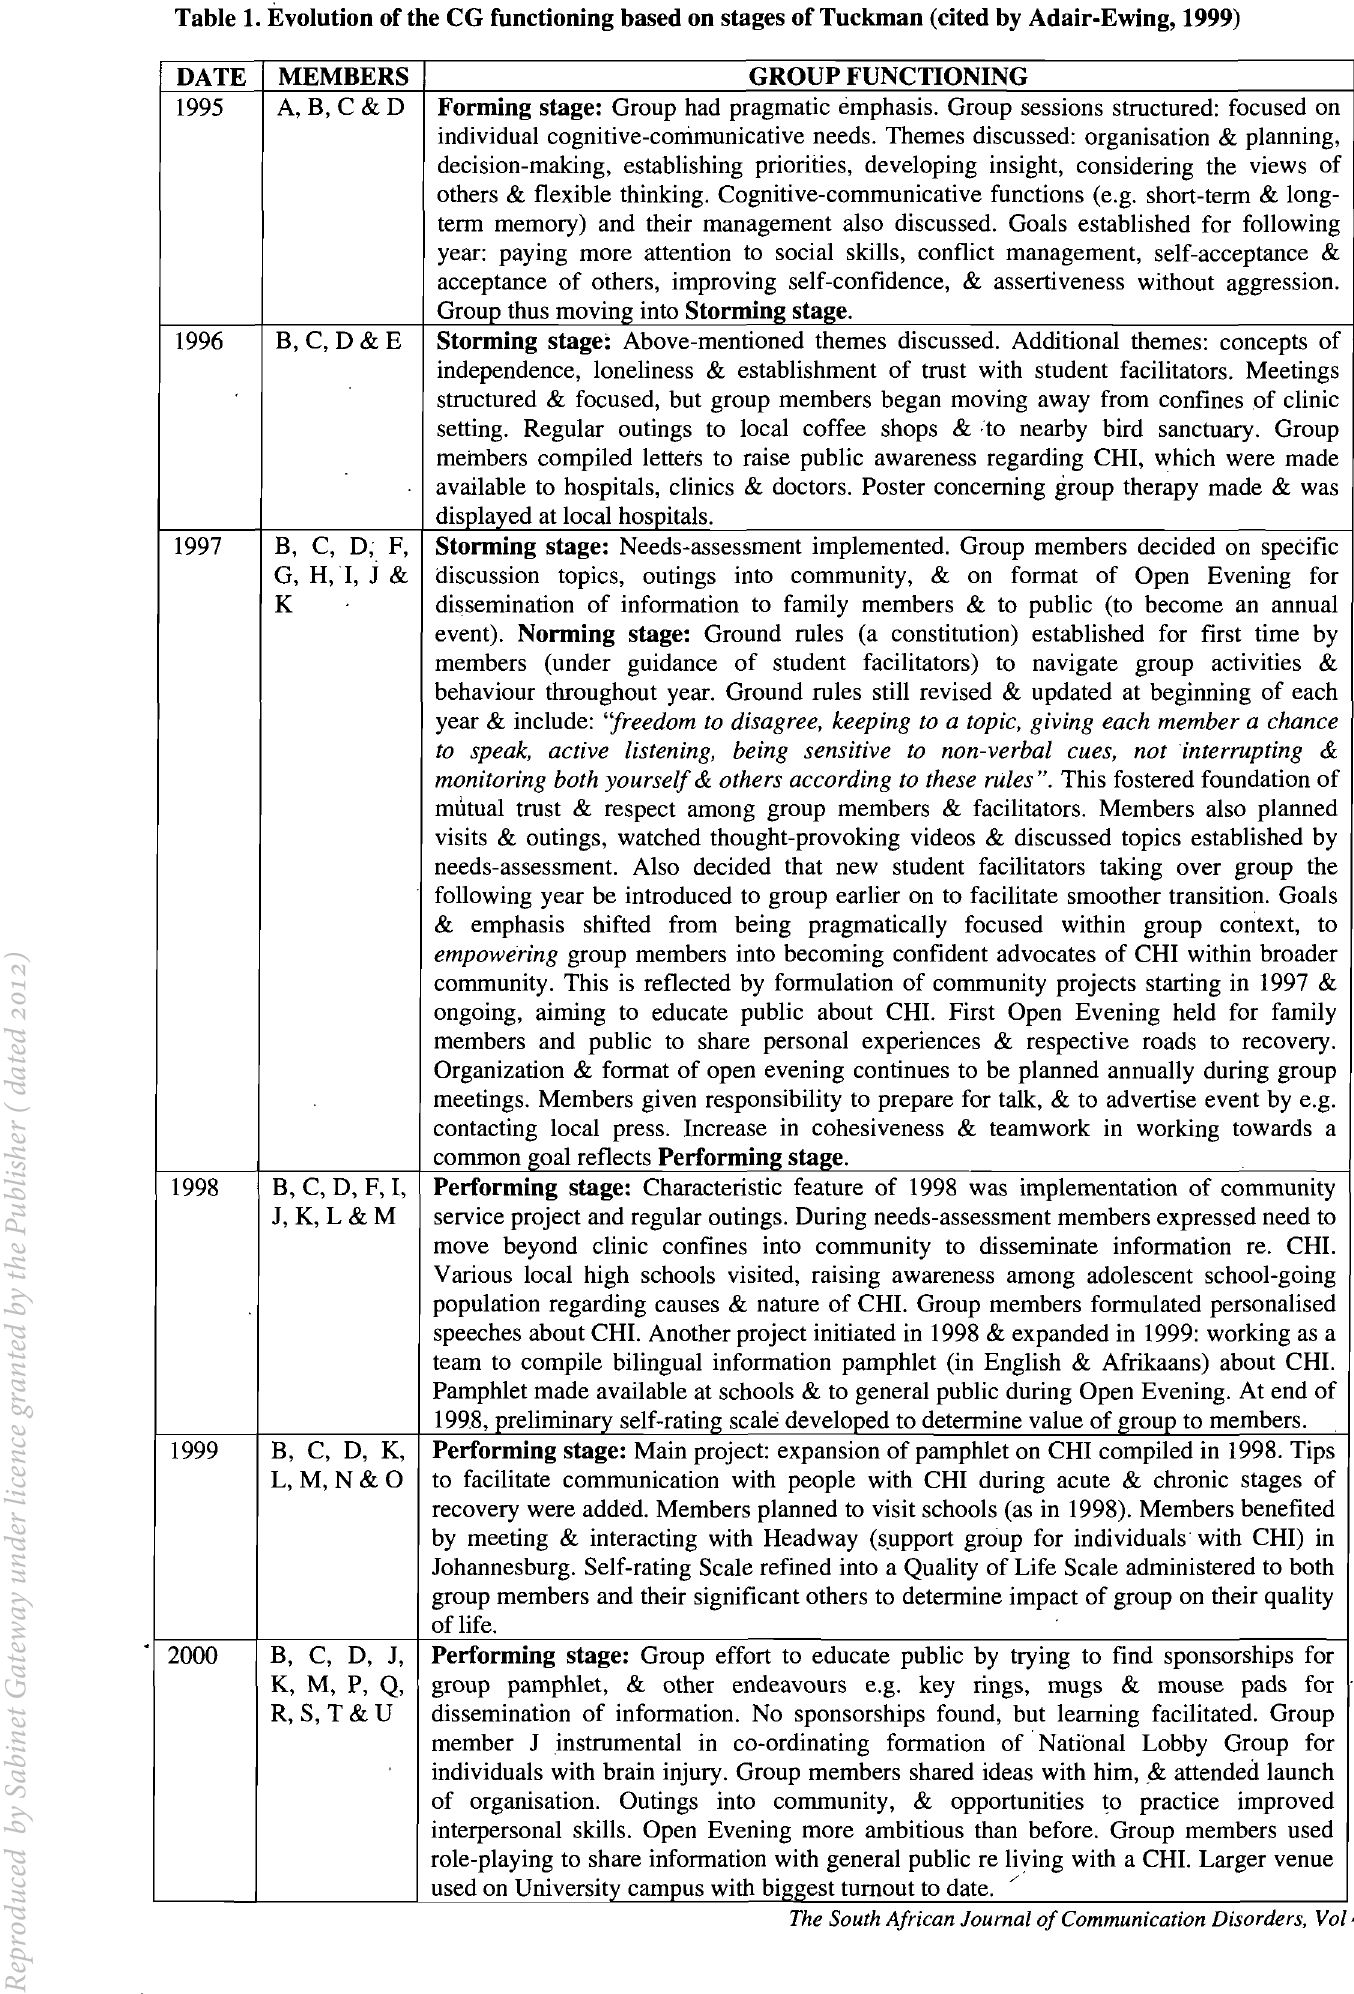
Table 1. Evolution of the CG functioning based on stages of Tuckman (cited by Adair-Ewing, 1999)